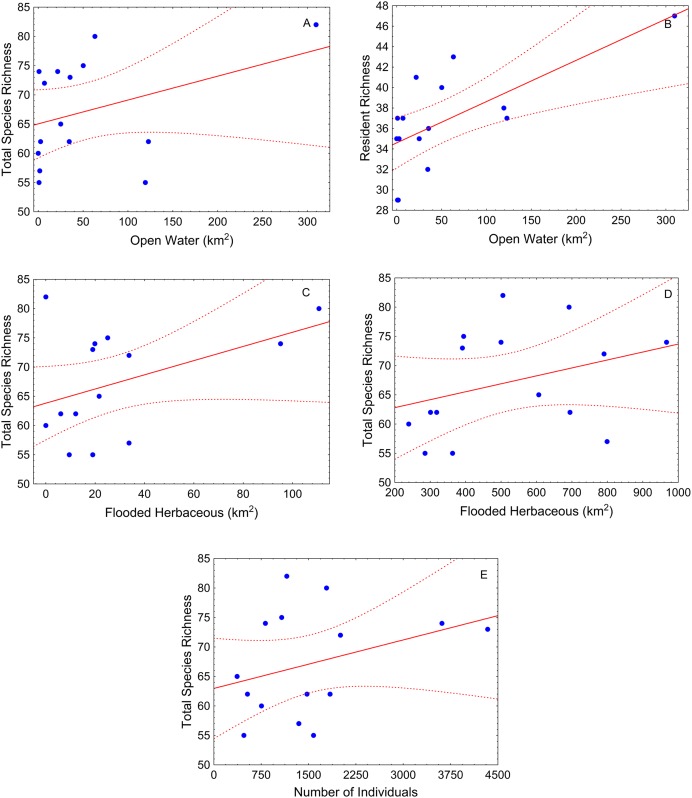
Scatter-plots by buffer during low-water season.At 1,000 m—(A) total species richness vs. open water, (B) resident richness vs. open water, and (C) total species richness vs. flooded herbaceous; and 5,000 m—(E) total species richness vs. flooded herbaceous and (F) total species richness vs. number of individuals. Tendency lines for the models with significative independent variables, where points are observed values of species richness per site, full lines are fitted lines and dotted lines are confidence intervals at 95%.